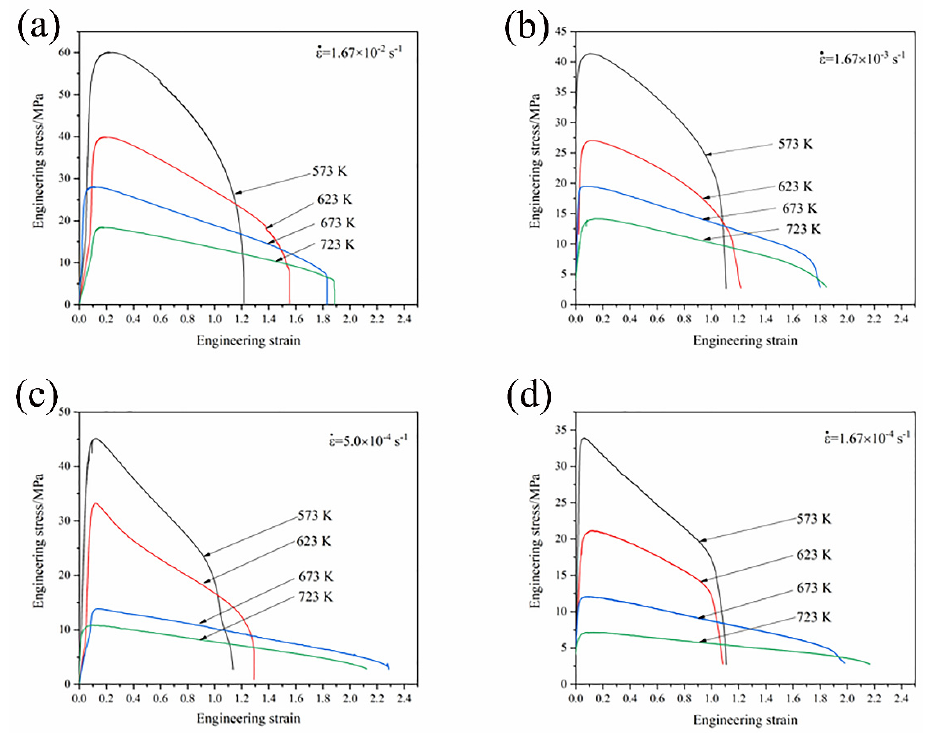
Figure 5. Engineering stress–strain curves of GAZ211 alloy at different temperatures and initial strain rates: ( a ) 1.67 × 10 − 2 s − 1 ; ( b ) 1.67 × 10 − 3 s − 1 ; ( c ) 5.0 × 10 − 4 s − 1 ; ( d ) 1.67 × 10 − 4 s − 1 .